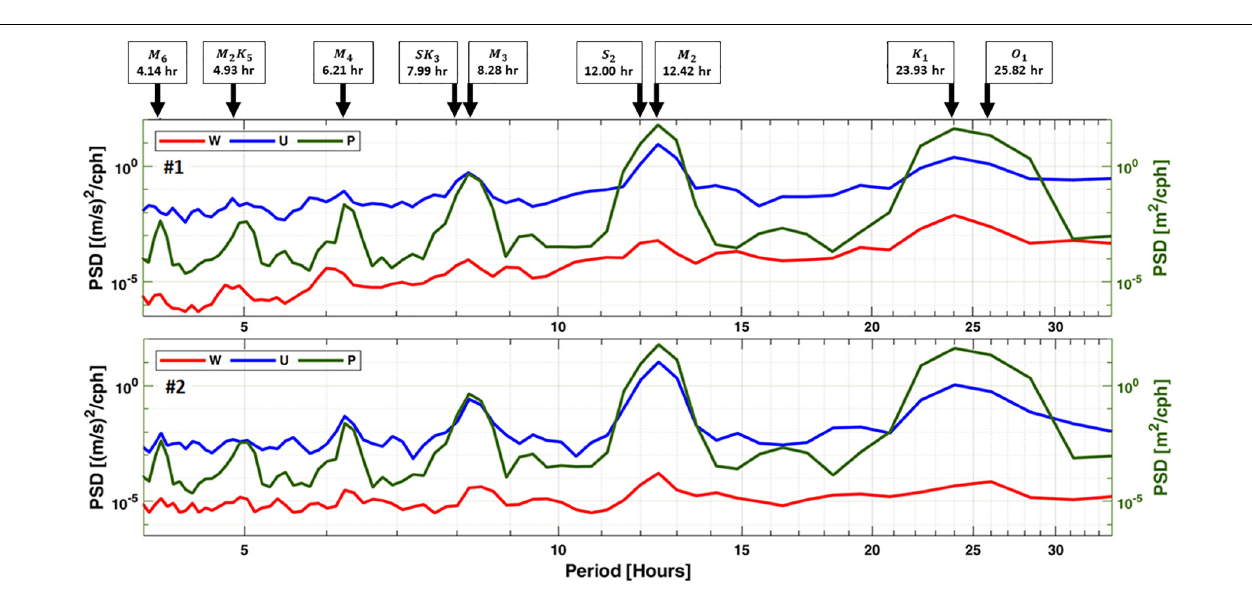
FIGURE 3 | Current structure between 15 and 27 July 2017 averaged from locations #1 and #2. (A) East-West currents. (B) North-South currents. (C) Current speed. (D) Vertical shear of horizontal currents.